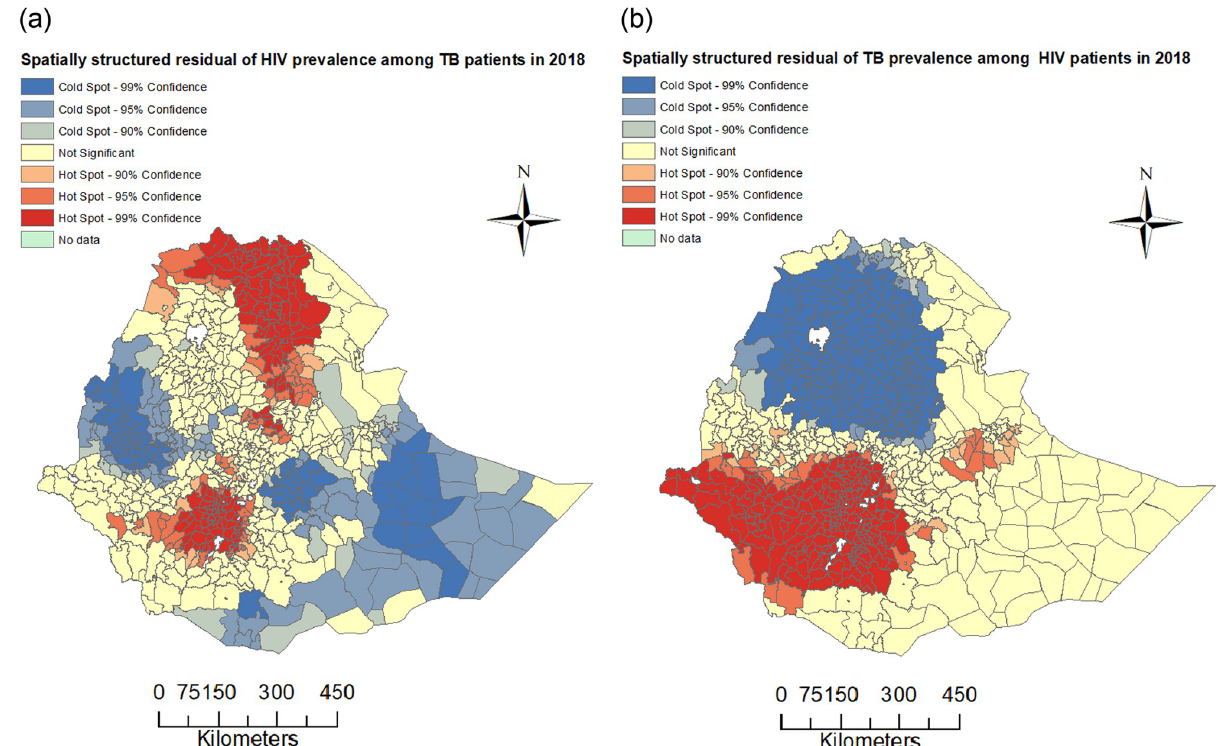
Fig 4. Spatial residual plot. Spatial clustering of spatially structured residuals from fitted BYM models to HIV among TB patients and TB among PLHIV data using the Getis-Ord G � i